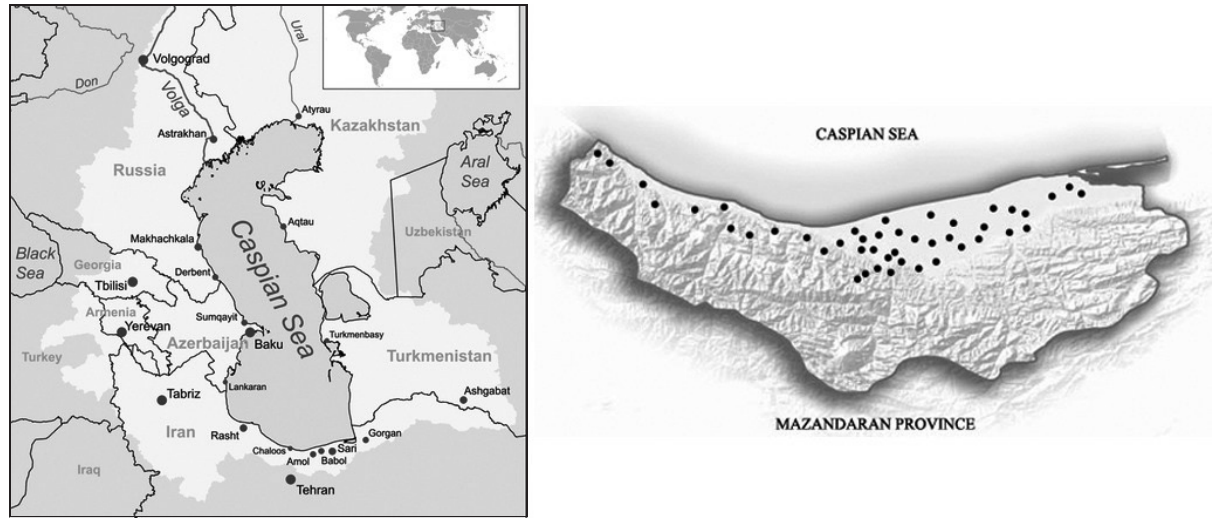
Figure 1. Sampling locations in Mazandaran province, northern